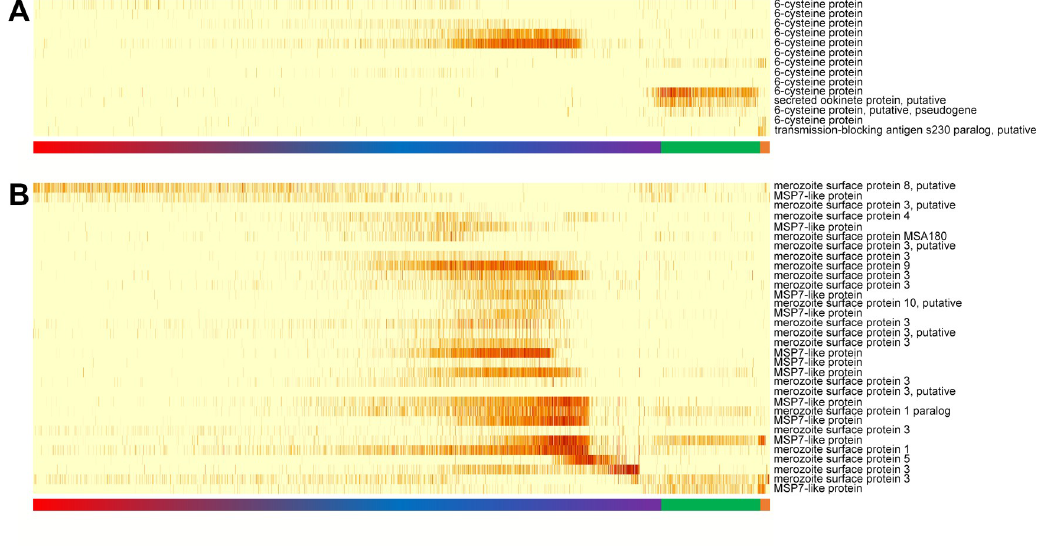
Fig 3. Expression of genes from multigene families. (A) Heatmap showing variations in the expression levels of 6-cysteine genes. (B) Heatmap showing variations in the expression levels of MSP genes. See legend of Fig 2 for details. Underlying data plotted in panels A and B are provided in S3 Data. MSP, merozoite surface